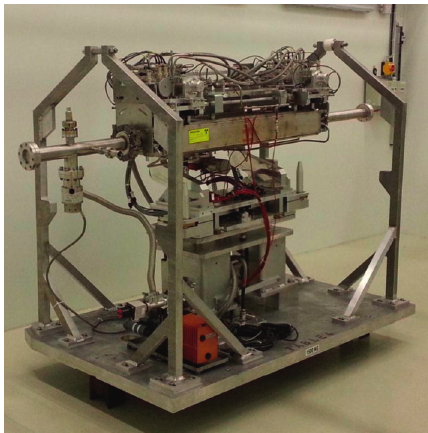
Figure 2: 3D view of a test stand: the fixed base (in black), the support table (blue), and the experimental test stand; in this ex- ample, an LHC collimator is